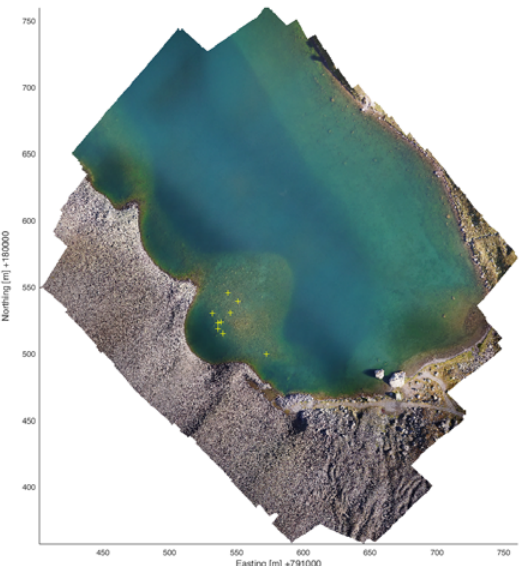
Figure 3. Footprints of images together with control points. The imaging quality is heterogeneous within the image block. Some images show excessive blurring. Further, the overall brightness varies. This has to be kept in mind when analysing the quality of image matching.